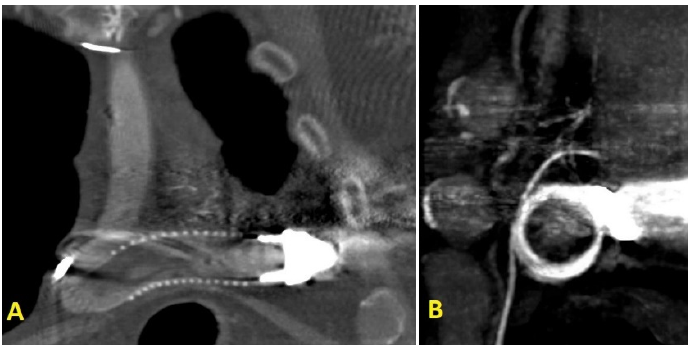
Figure 1. ( A ) chest CT-scan coronal-view focused on of LVAD outflow-graft; ( B ) CT-scan sagittal-view showed an image suggesting a thrombus in the proximal part of the LVAD outflow-graft.